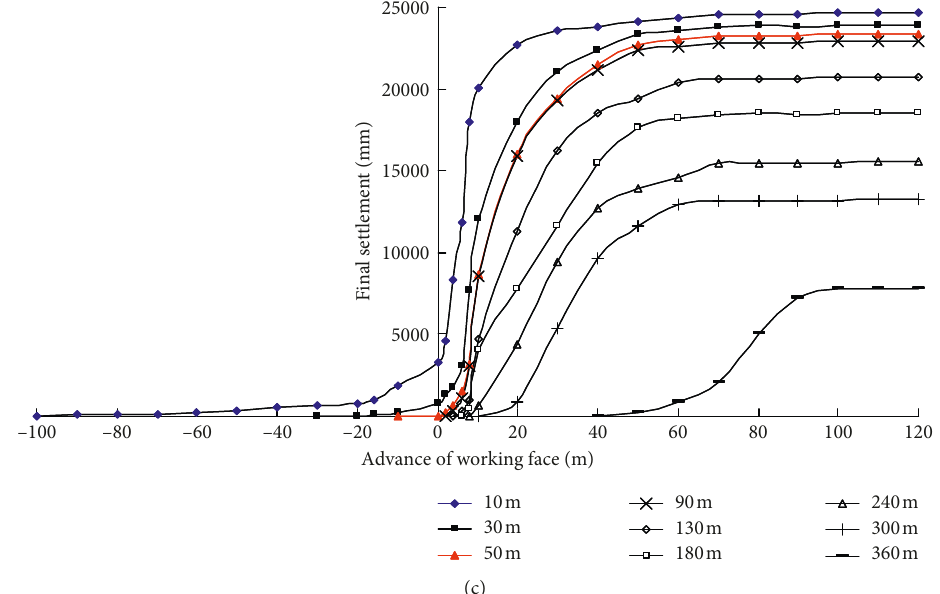
Figure 9: Variety of overlying strata convergence with advance of working face in different thick coal seams. (a) 9.0m; (b) 15.0m; (c)